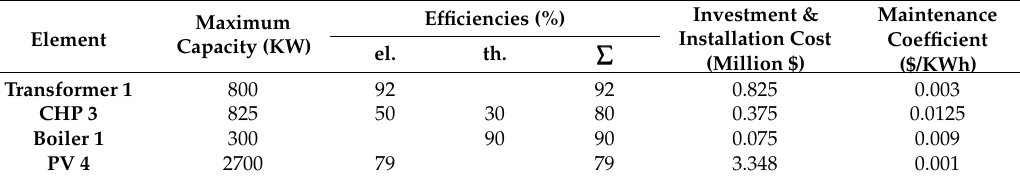
Table 4. Characteristic of the chosen elements.